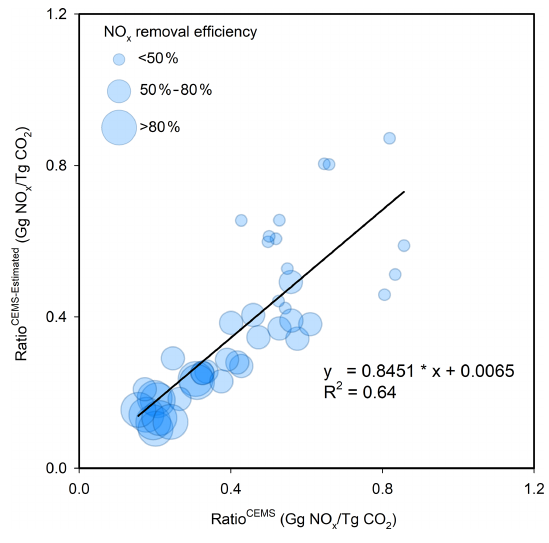
Figure 6. Scatterplot of ratio CEMS-estimated as compared to ratio CEMS for 2016. All 44 coal-fired power plants that operated post-combustion devices after 2005 and before 2016 (including 2016) are used in the plot. The sizes of the circles denote the mag- nitude of the NO x reduction efficiency of post-combustion control devices estimated in this study. The line represents the linear regres- sion of ratio CEMS to ratio CEMS-estimated